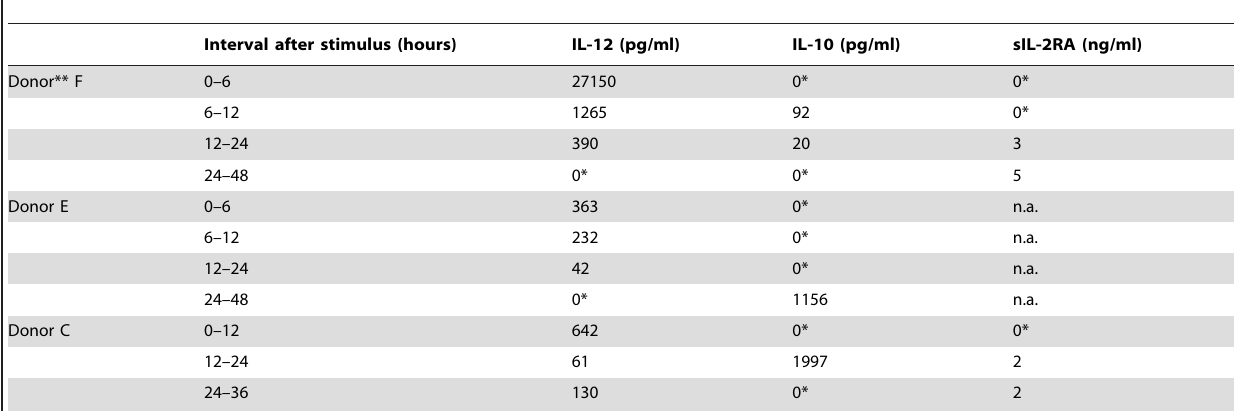
Table 1. sequential expression of freshly secreted IL-12, IL-10 and sIL-2RA of LPS/IFN- c matured DCs.